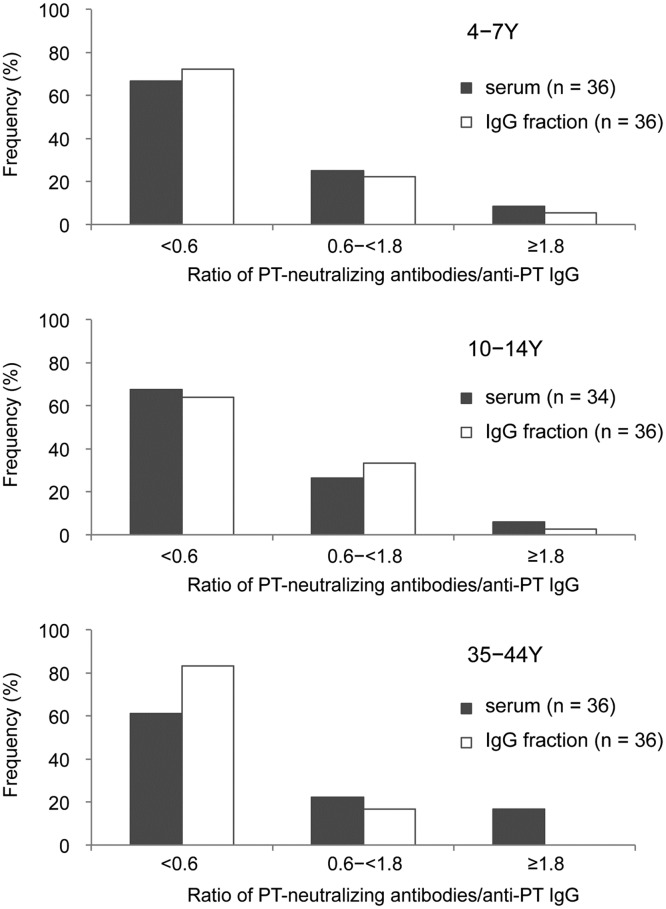
Comparing the ratio of PT-neutralizing antibodies to anti-PT IgG between the serum and purified IgG fractions from young children, older children, and adults.The IgG fractions were purified from serum samples that were collected in 2014, and the ratios of PT-neutralizing antibodies (titer) to anti-PT IgG (IU/mL) were compared. The age groups were 4–7 years, 10–14 years, and 35–44 years. Numbers in parentheses indicate the number of samples that were analyzed. Y, years. The frequencies of the serum and IgG fraction ratios were significantly different among the adults (p = 0.016), but not among young and older children (p > 0.05), indicating that the adults with the highest ratio ≥1.8 had non-IgG anti-PT immunoglobulins.